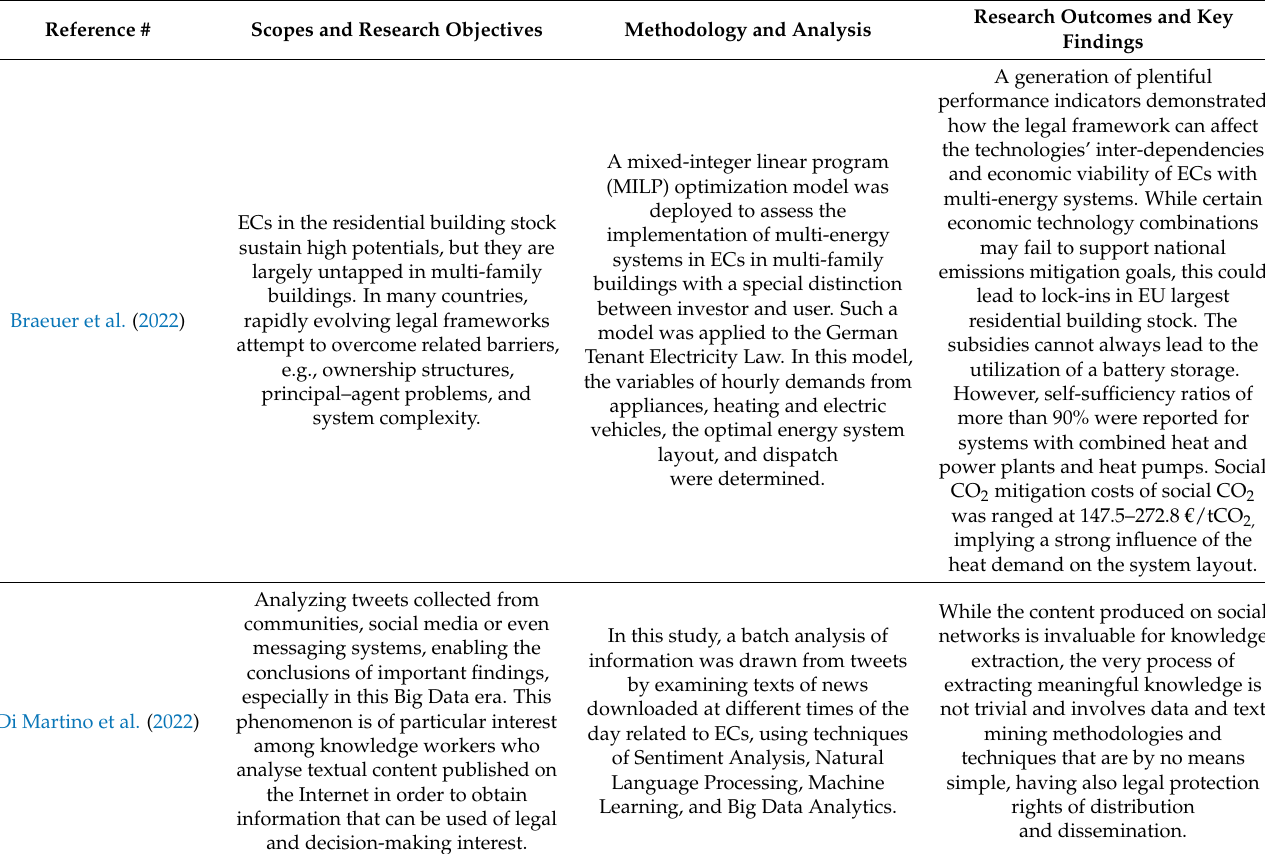
Table 10. The context of legislative framework—Group 3 (studies are presented in reverse chronolog- ical order and in last name of first author alphabetical